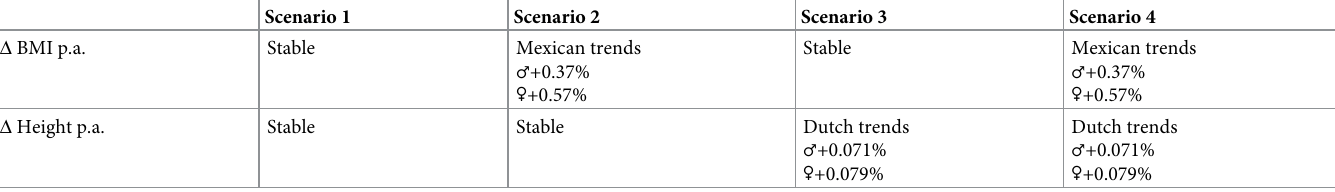
Table 1. Overview of the four